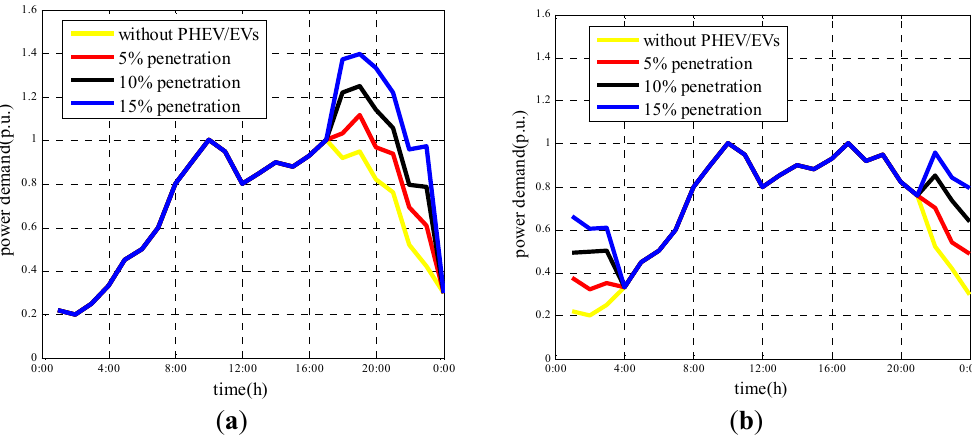
Figure 4. Power demand of a community for different PHEV/EV penetrations: ( a ) without rescheduling the charging period and ( b ) with rescheduling the charging